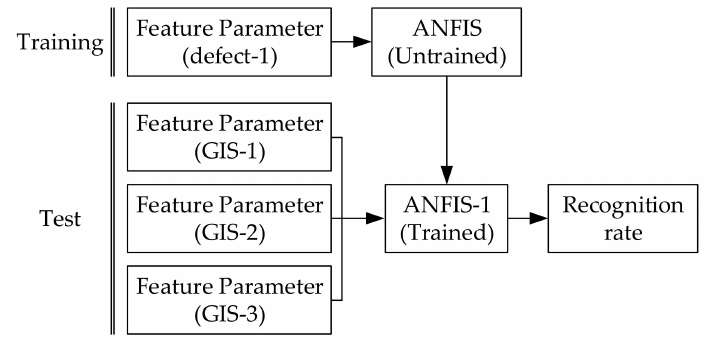
Figure 17. Discriminator training